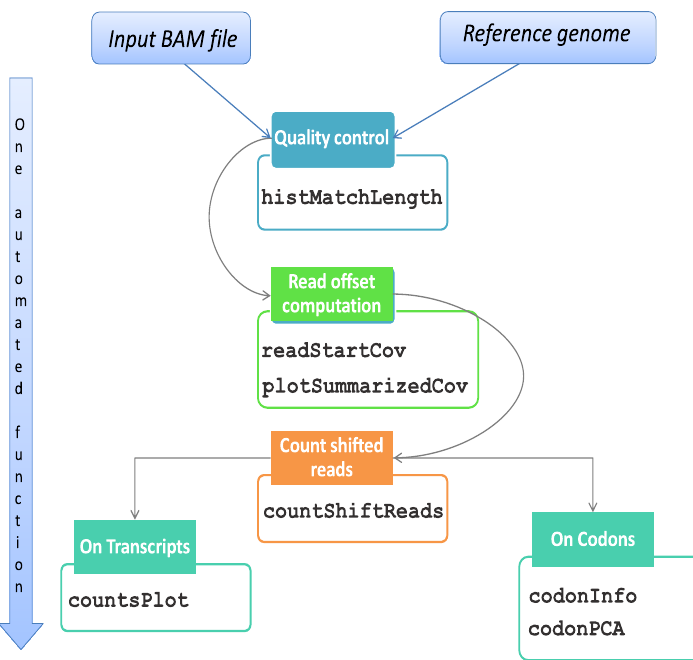
Figure 1. Workflow of ‘RiboProfiling’ Ribo-seq analysis from BAM to quantification on genomic features and codon motifs.